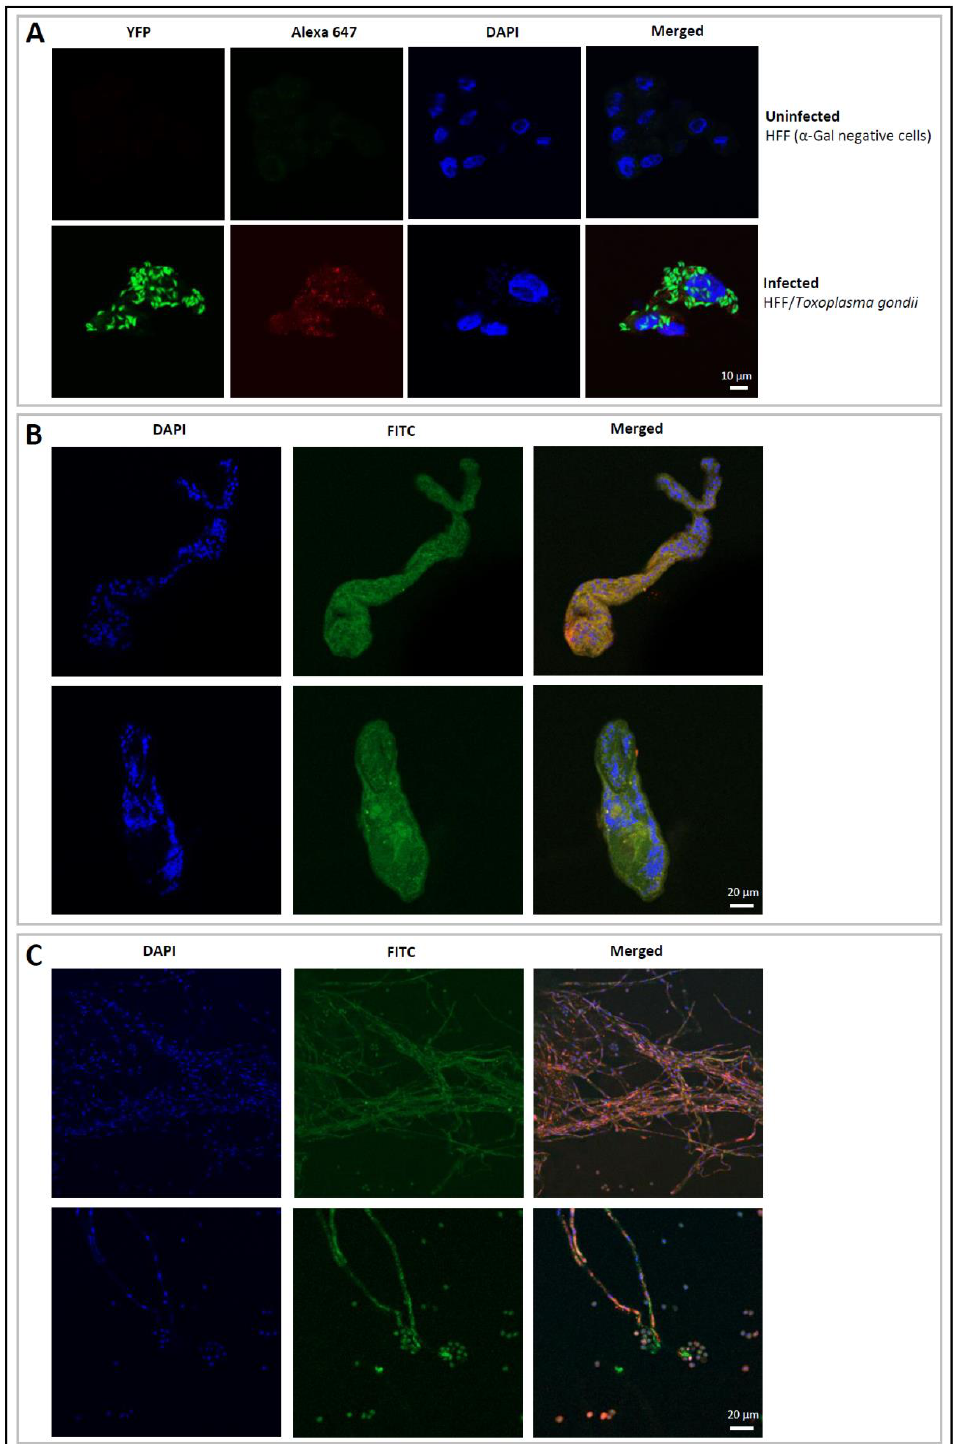
Figure 2. Expression of the terminal α-Gal moieties on the surface of Toxoplasma gondii tachyzoites ( A ); Schistosoma mansoni cercariae ( B ) and Aspergillus fumigatus conidia ( C ) assessed by immunofluorescence. Uninfected human foreskin fibroblast (HFF) cells, which do not express α-Gal, served as a negative control ( A ). The α-Gal-specific monoclonal antibody M86 (primary antibody) and the Alexa Fluor ® 647 goat anti-mouse IgM (secondary antibody) were used to detect the production of α-Gal in Toxoplsma gondii tachyzoites expressing yellow fluorescent protein (YFP) ( A ). Goat anti-mouse IgM-FITC was used as secondary antibody for detection of α-Gal (green) in Schistosoma manosni ( B ) and Aspergillus fumigatus ( C ). Cell nuclei were stained with DAPI (blue) ( A – C